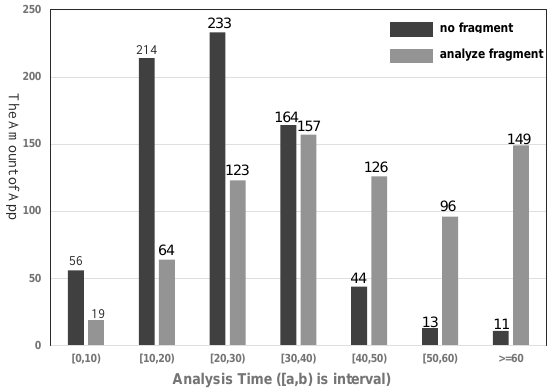
Figure 13. Distribution of Analysis Time for Popular Apps